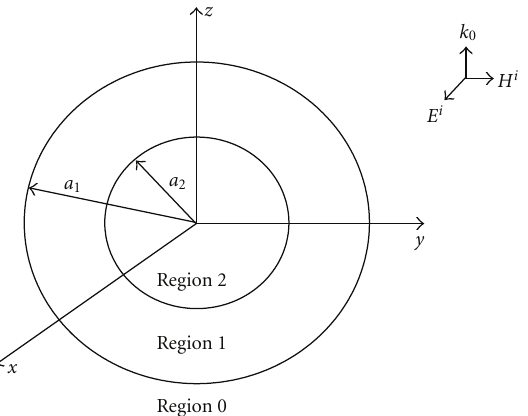
Figure 1: The geometry of scattering of a plane wave by an aniso- tropic plasma-coated conducting